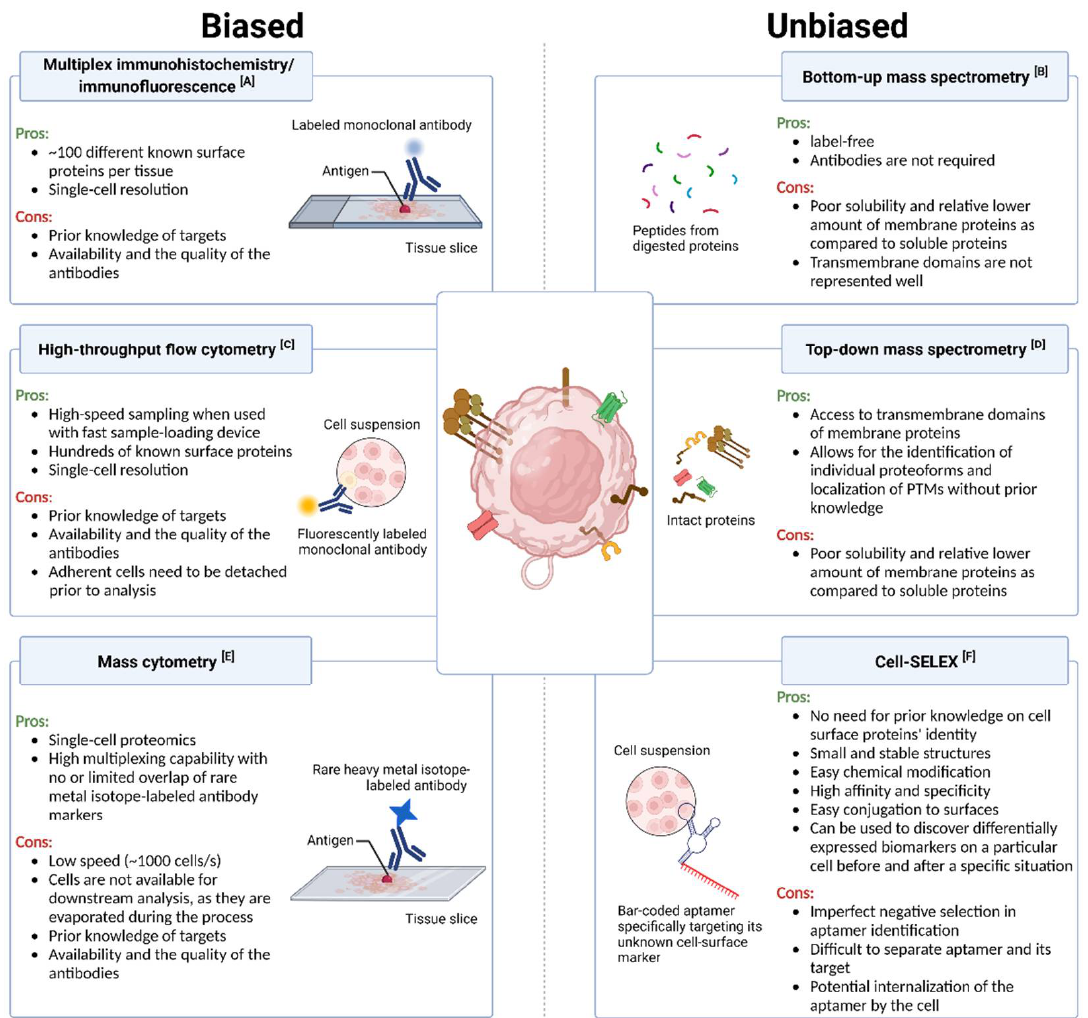
Figure 3. Comparison of main tools for plasma membrane identification. Biased techniques are based on known surface proteins and a labeled recognition element to detect them. Unbiased methods do not require prior knowledge of the protein’s identity, and they are label-free. References as follows: for panel A [33,34], panel B [41,42], panel C [37,38,108], panel D [40,68,69,71,73,75], panel E [84,87,89,109,110] and panel F [43,111,112].